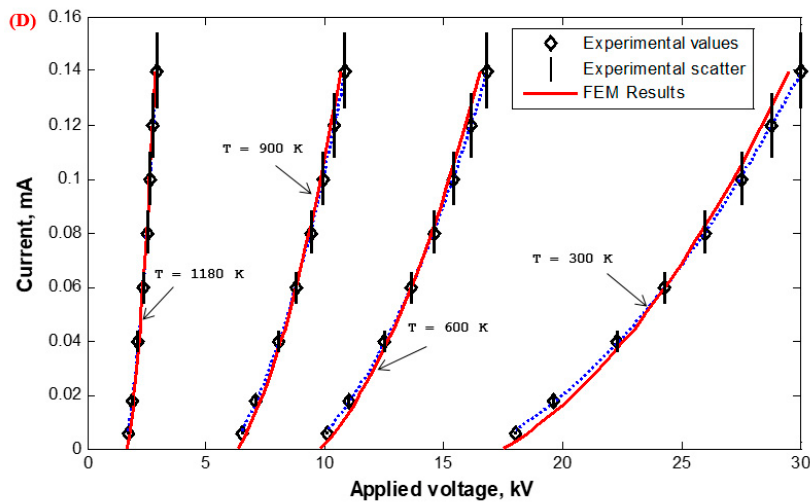
Figure 23. FEM molding and measured values experimentally for the I–V characteristics of WDESP ( r c = 0.26 mm) with high-temperature incoming gases for ( A ) single wire, ( B ) multi-discharge wire (three-wire), ( C ) multi-discharge wire (five-wire), and ( D ) multi-discharge wire (seven-wire).